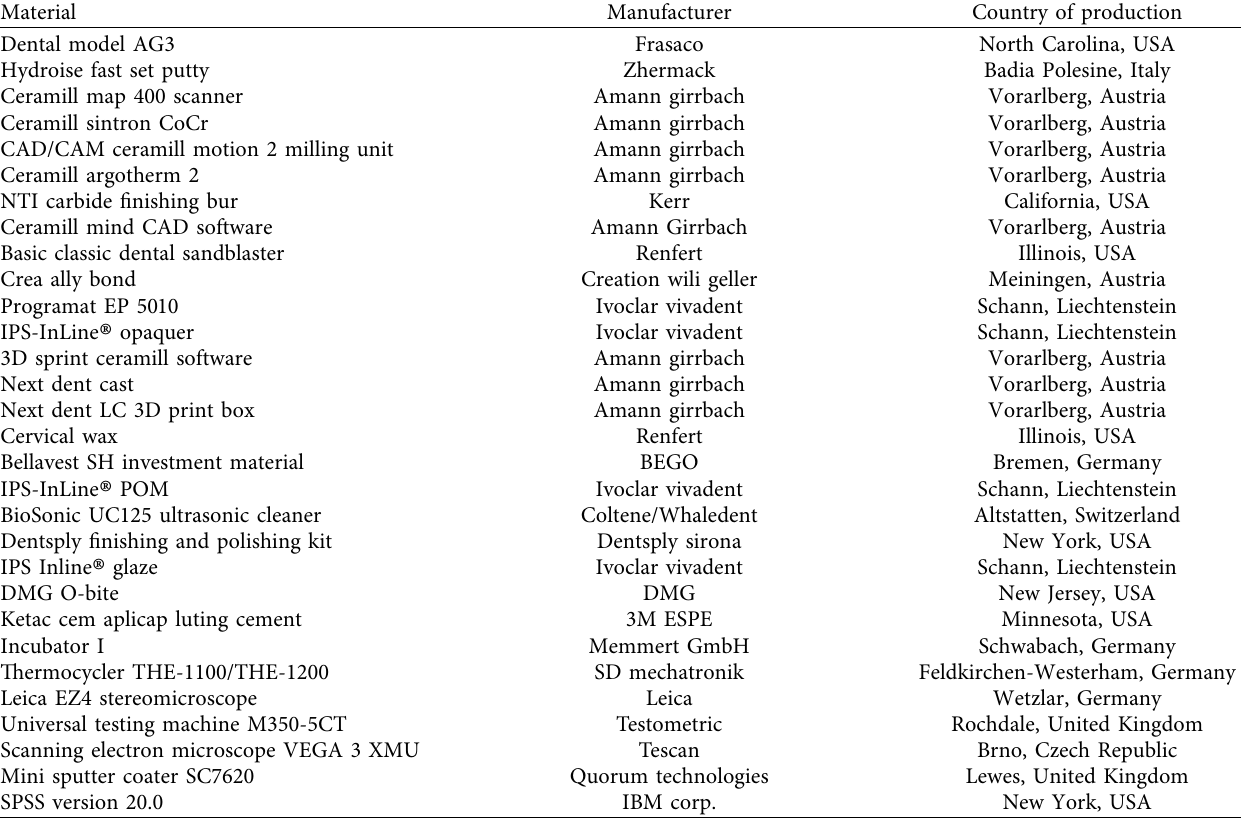
Table 1: Materials with corresponding manufacturer.